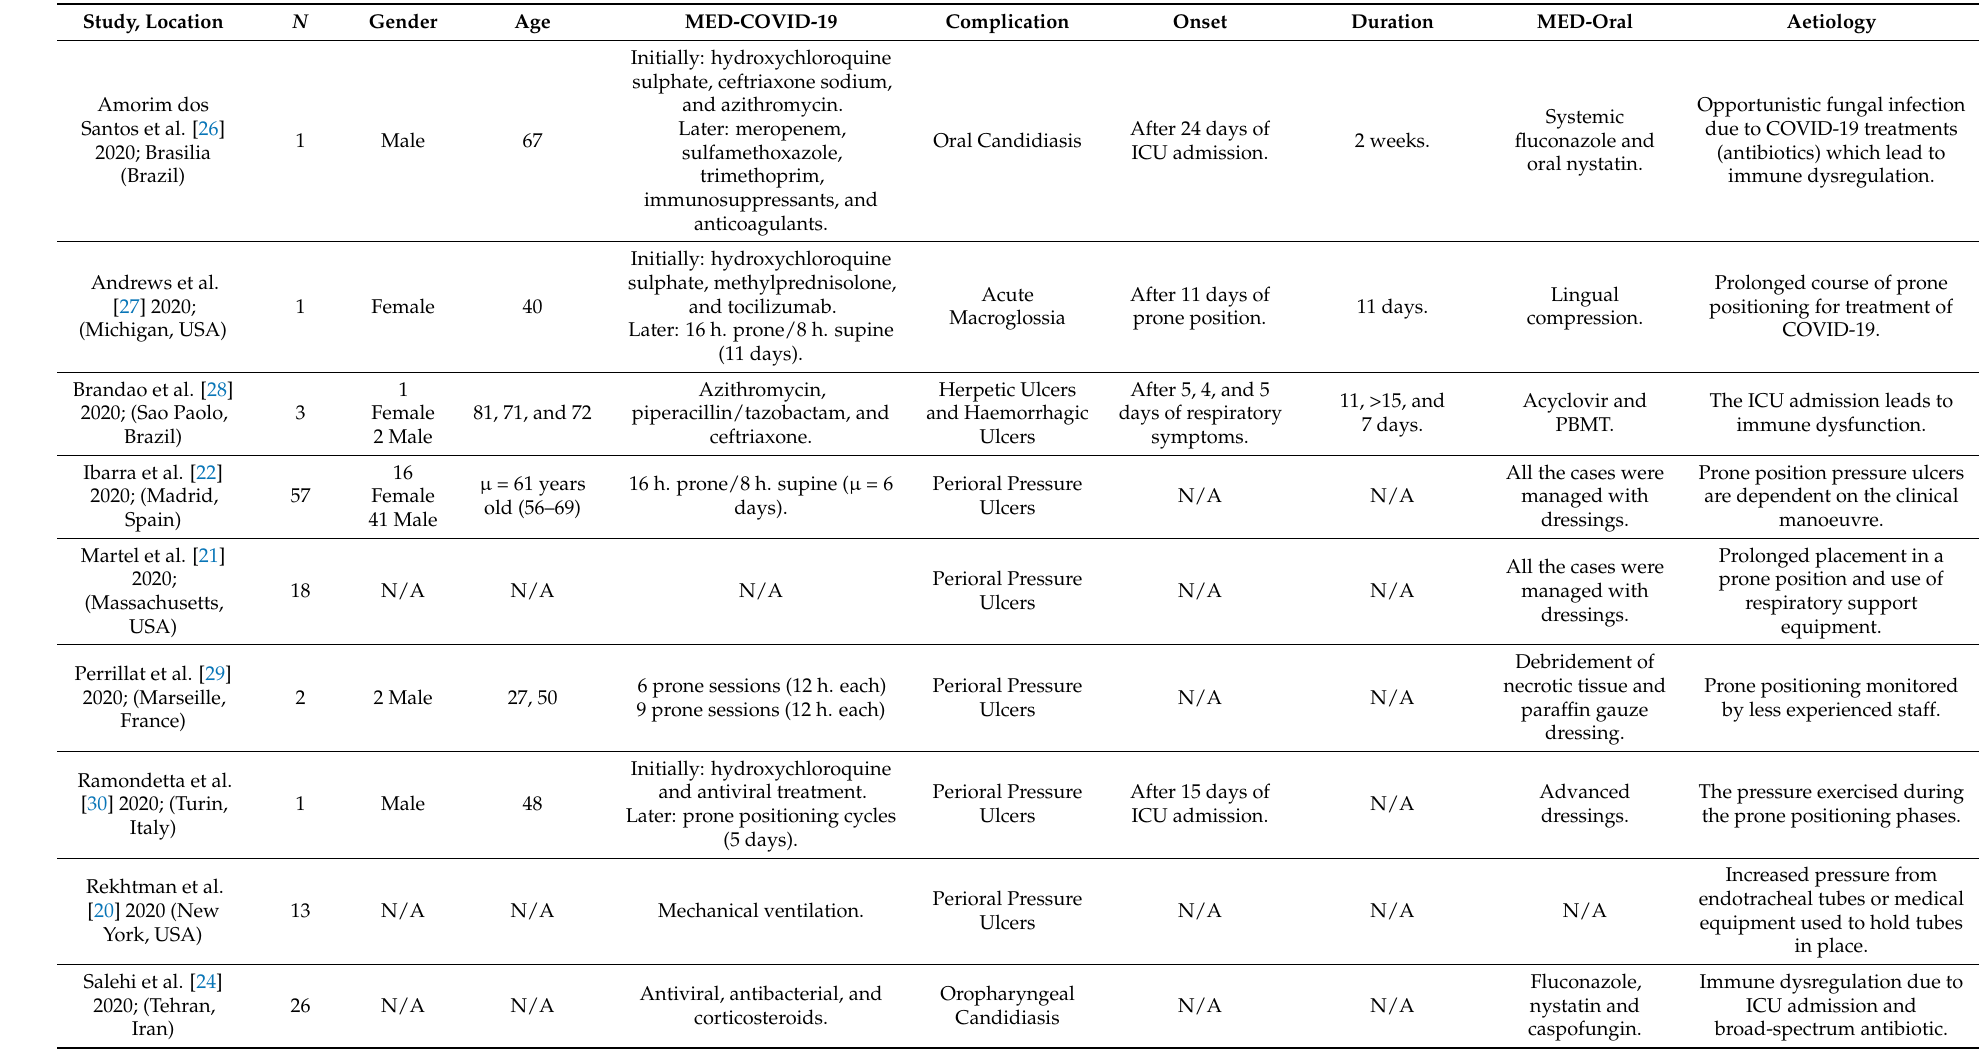
Table 2. Summary of the oral complications of ICU patients with